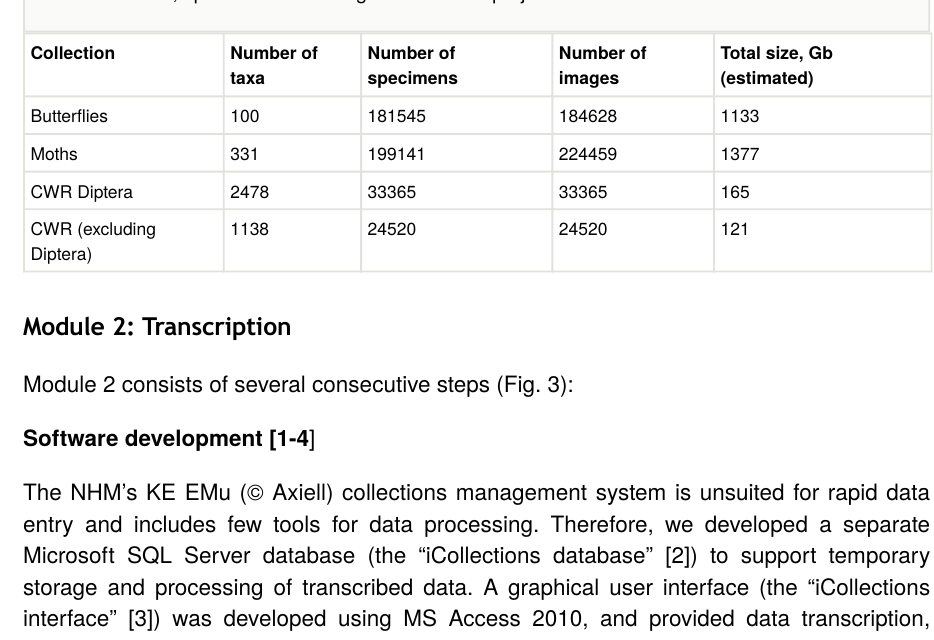
Number of taxa, specimens and images in di ff erent